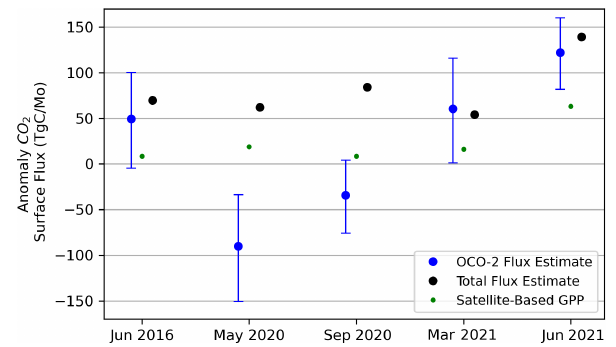
Figure 9. OCO-2 can roughly estimate extreme surface CO 2 flux anomalies. OCO-2 estimation of extreme surface CO 2 flux anoma- lies in the Western US target domain. Total CO 2 flux anomaly esti- mates are estimated from a combination of a dynamic global vegeta- tion model (LPJ) and wildfire model reanalysis estimates. Error bars are determined from bootstrapped error estimates (see Sect. 3.3.2). Fossil fuel anomalies are negligible in magnitude compared to the biosphere and fire sources (see Fig.